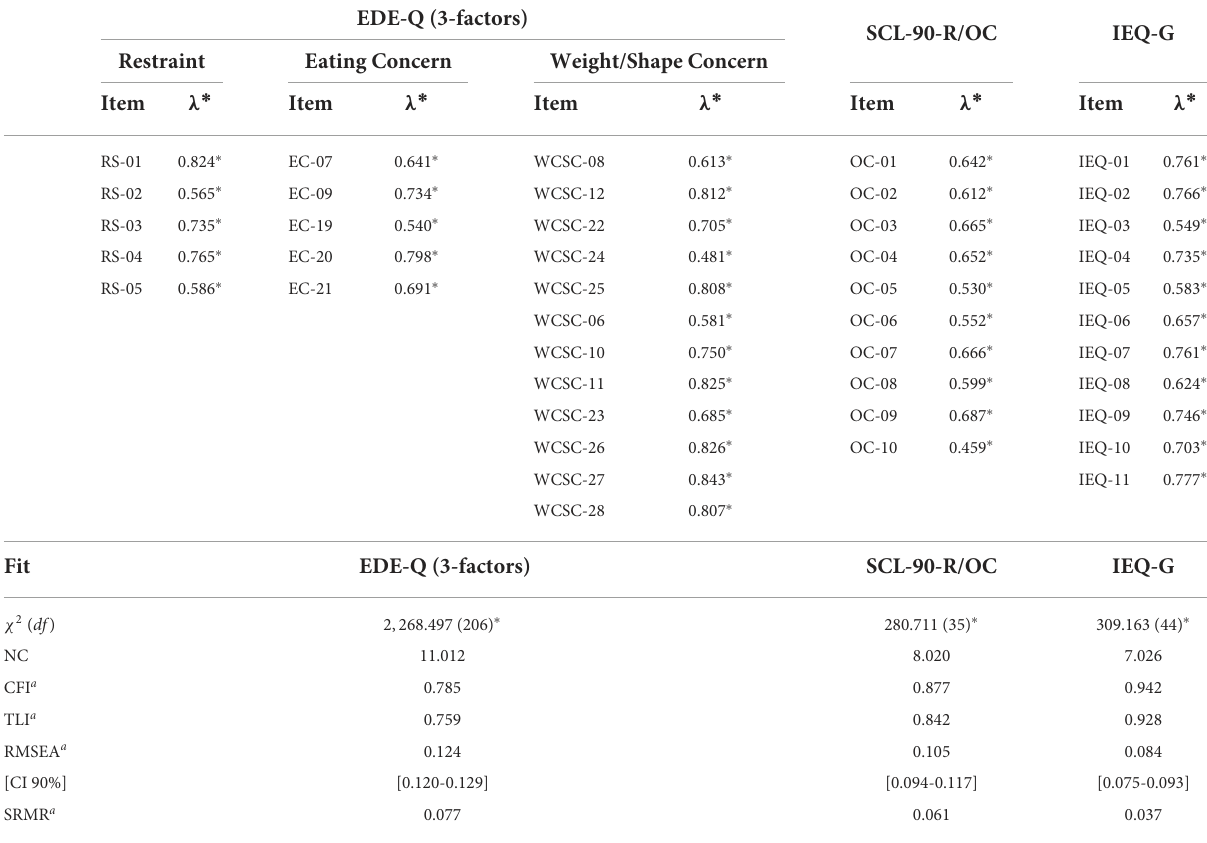
TABLE 3 Standardized loadings and robust fit statistics of the three CFA models estimated separately. EDE-Q (3-factors) Restraint Eating